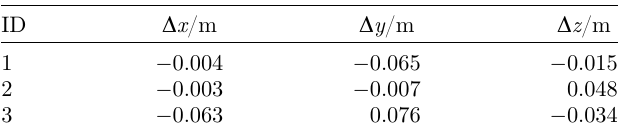
Table 3. Deviation of averaged detected to nominal coordinates of the reference sources.